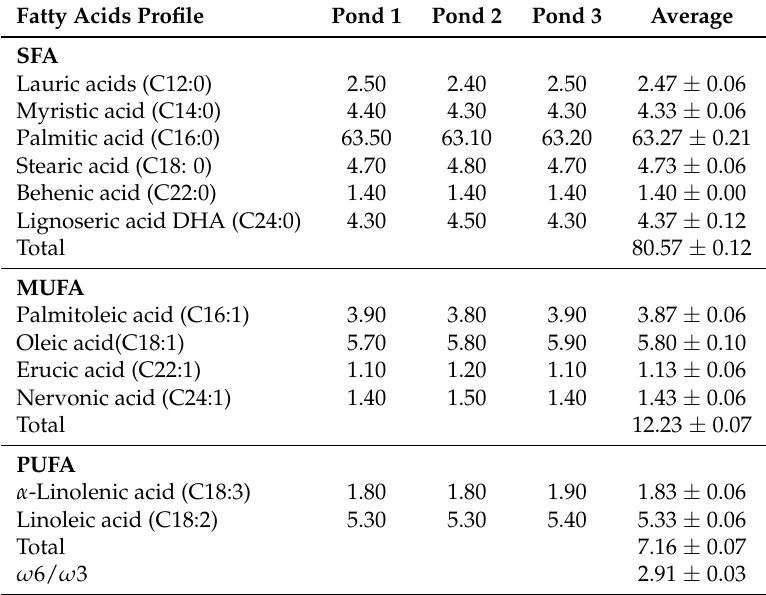
Table 3. Gas chromatography determination of fatty acid composition (g fatty acid methyl esters/100 g total fat) of cultivated C. racemosa